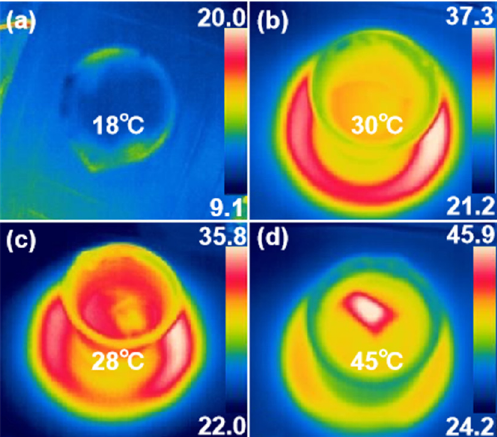
Figure 11. Infrared thermal imaging photos: ( a ) Pure water evaporation system in dark; Pure water evaporation system ( b ), CFs-foam water evaporation system ( c ) and PB/PPy@CFs-foam water evaporation system ( d ) after continuous irradiation for 15 min at 1 kW · m − 2 .